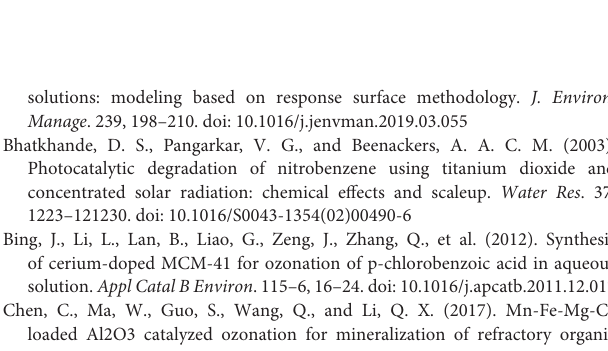
Figure S1 | Schematic representation of the experimental setup. Figure S2 | SEM images and EDX spectra of NaY (a) and USY (b) . Figure S3 | TEM images of NaY (a) and USY (b) . Figure S4 | TOC removal in adsorption process with Y